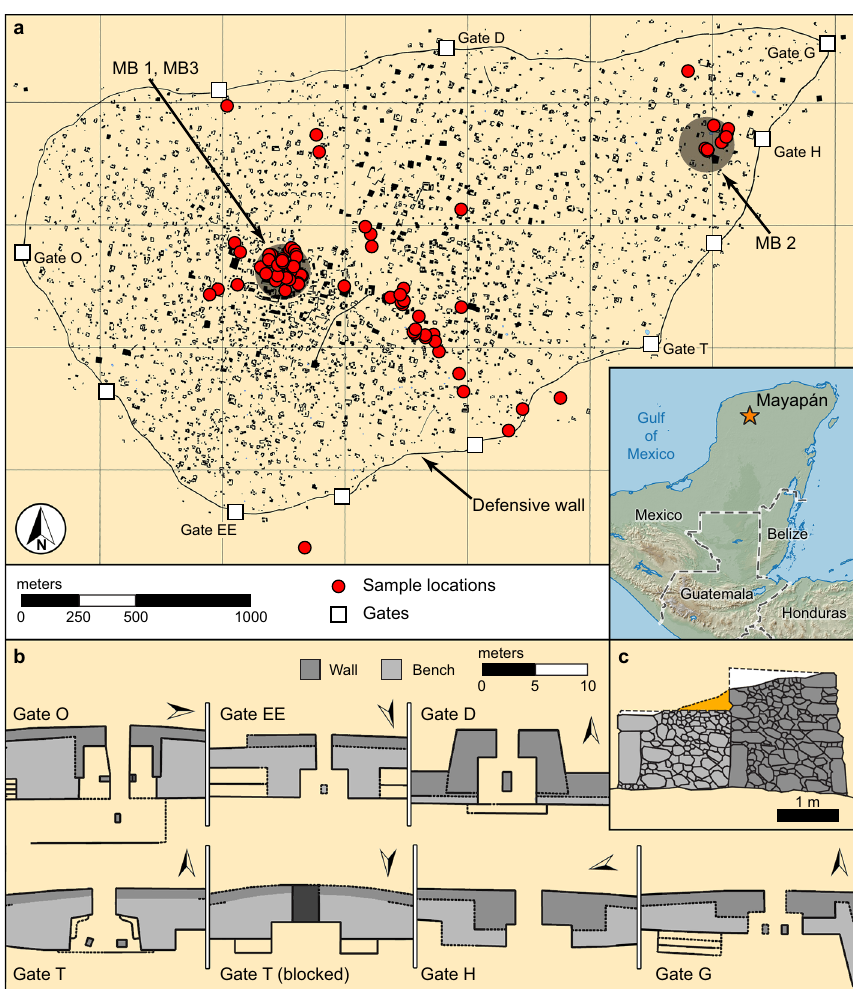
Fig. 1 Map of Mayapan. a Layout of the city showing housing complexes, the defensive wall, formal gates, and the locations of skeletal samples (red dots). b Gate and wall con fi gurations adapted from 43 . c Cross-section of the tiered double-wall construction surrounding Mayapan. MB, Mass